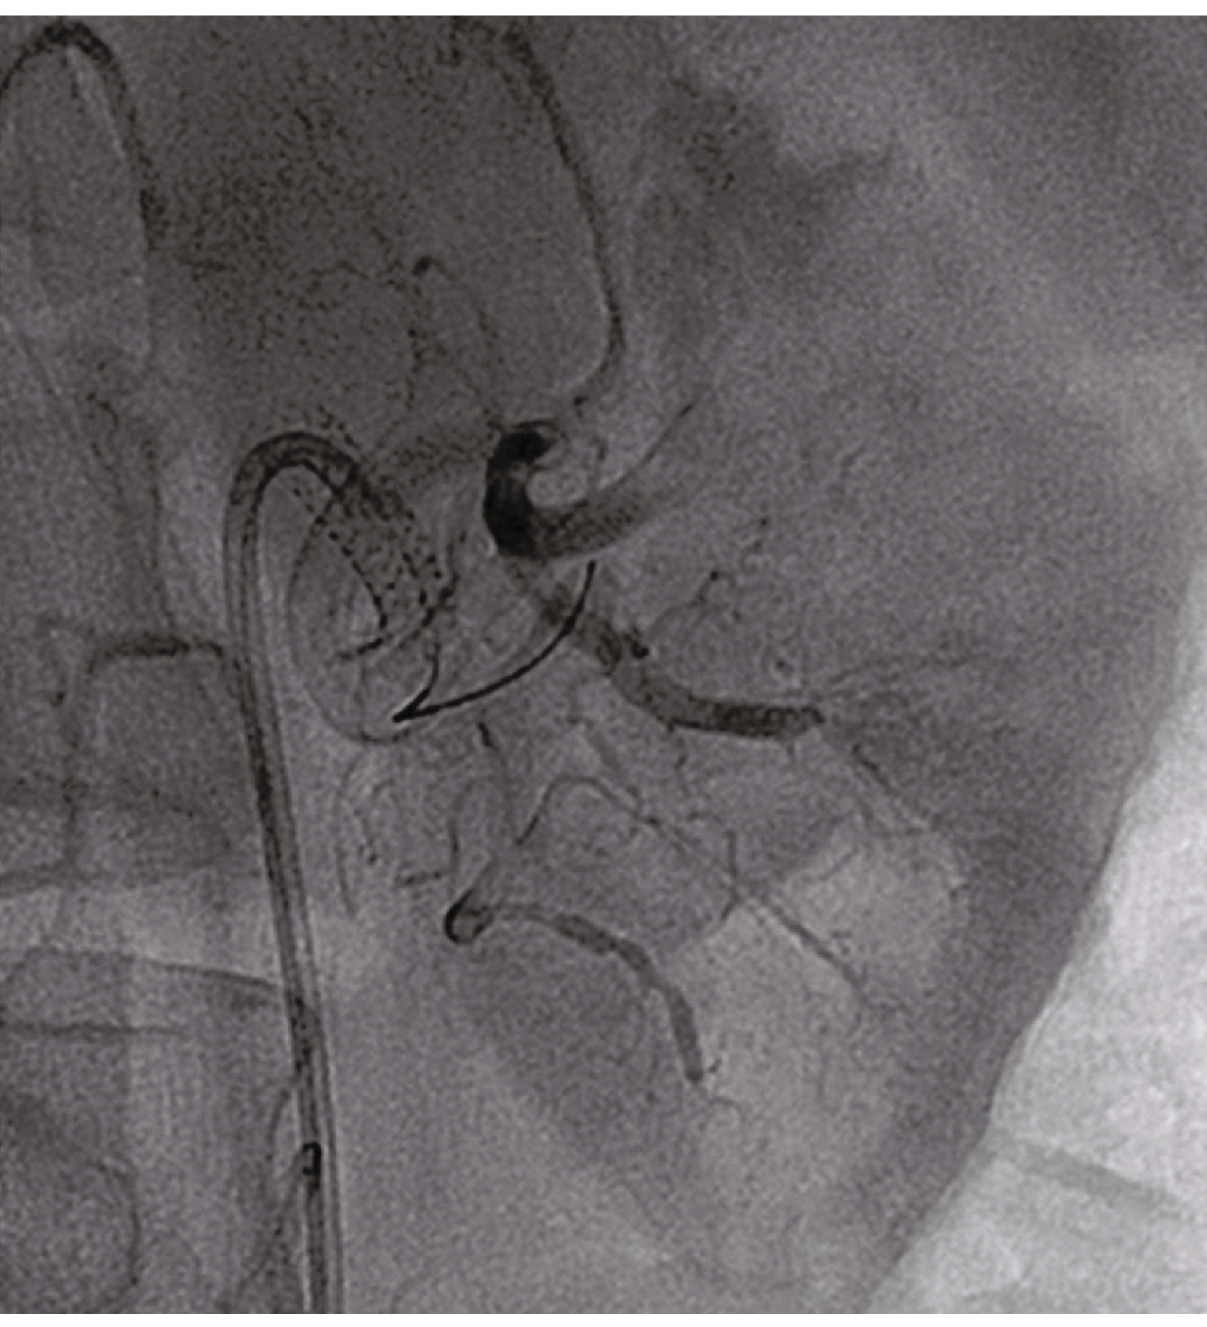
Figure 6: After stenting of the ostium, renal blush is